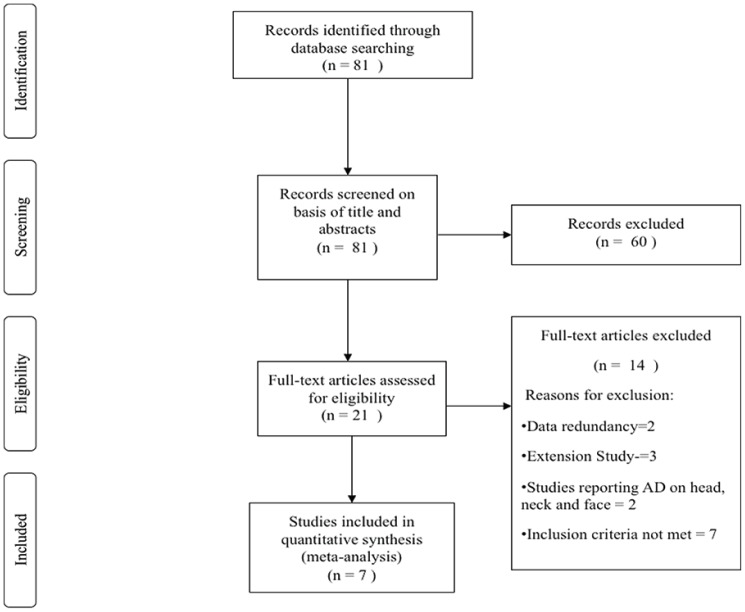
Flowchart of trials.